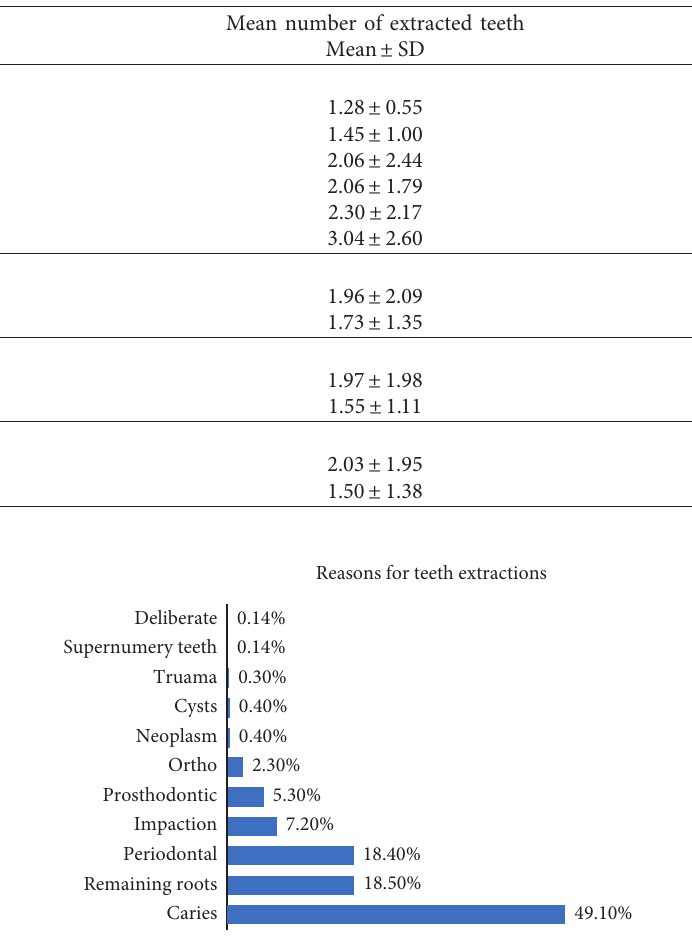
Figure 1: Distribution of reasons for teeth extractions in patients. Table 3: Distribution of reasons for teeth extractions among patients by gender, nationality, and type of dental